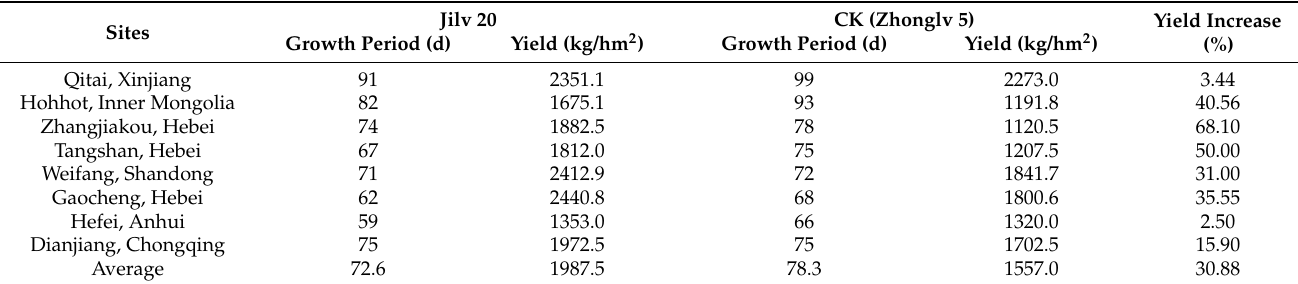
Table 8. Yield performance of Jilv 20 in a production trial in